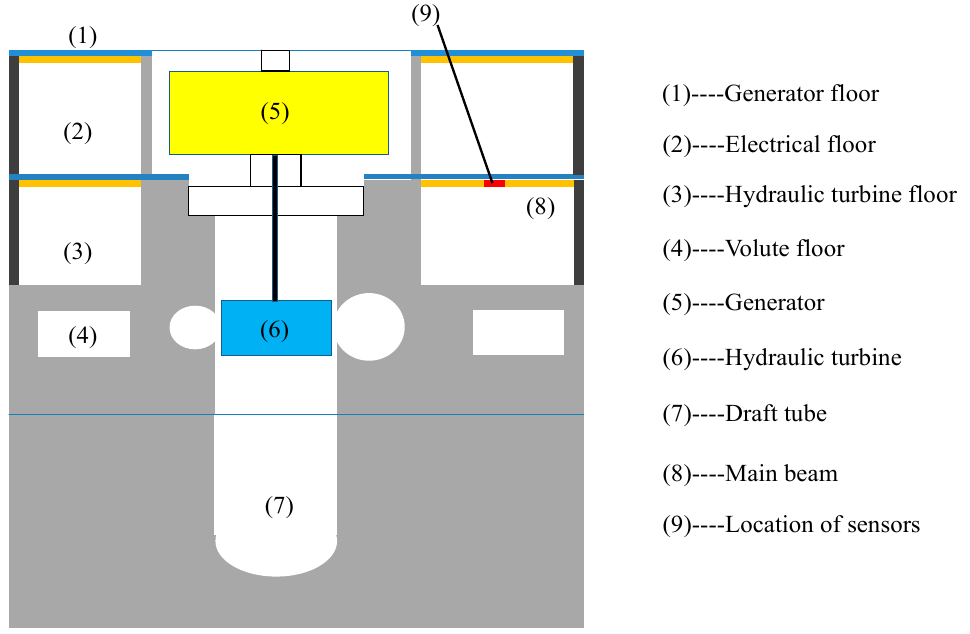
Figure 5. Powerhouse structure and location of sensors.